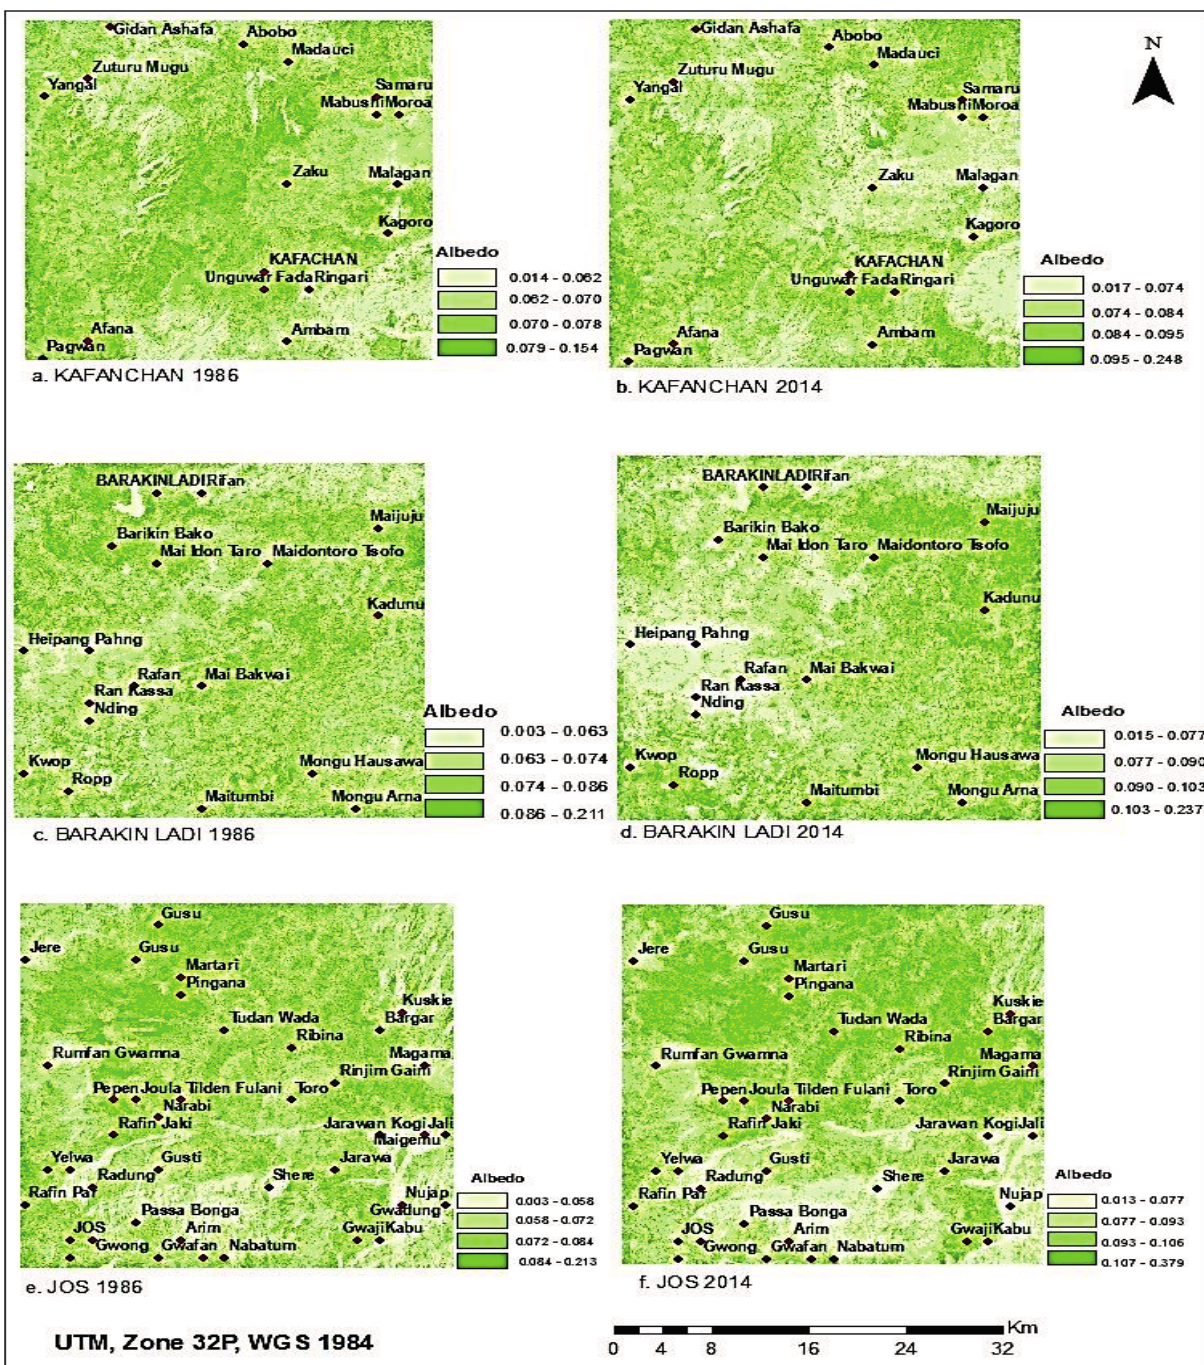
Figure 6. Albedo change in the three